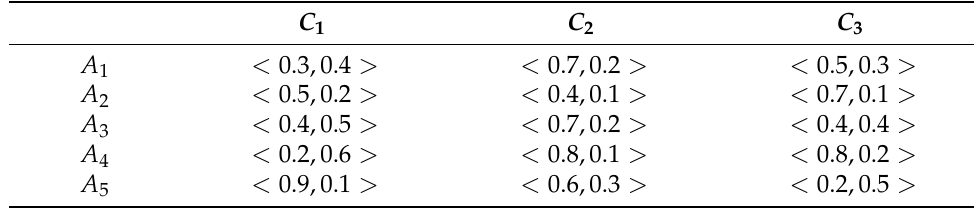
Table 9. Intuitionistic decision